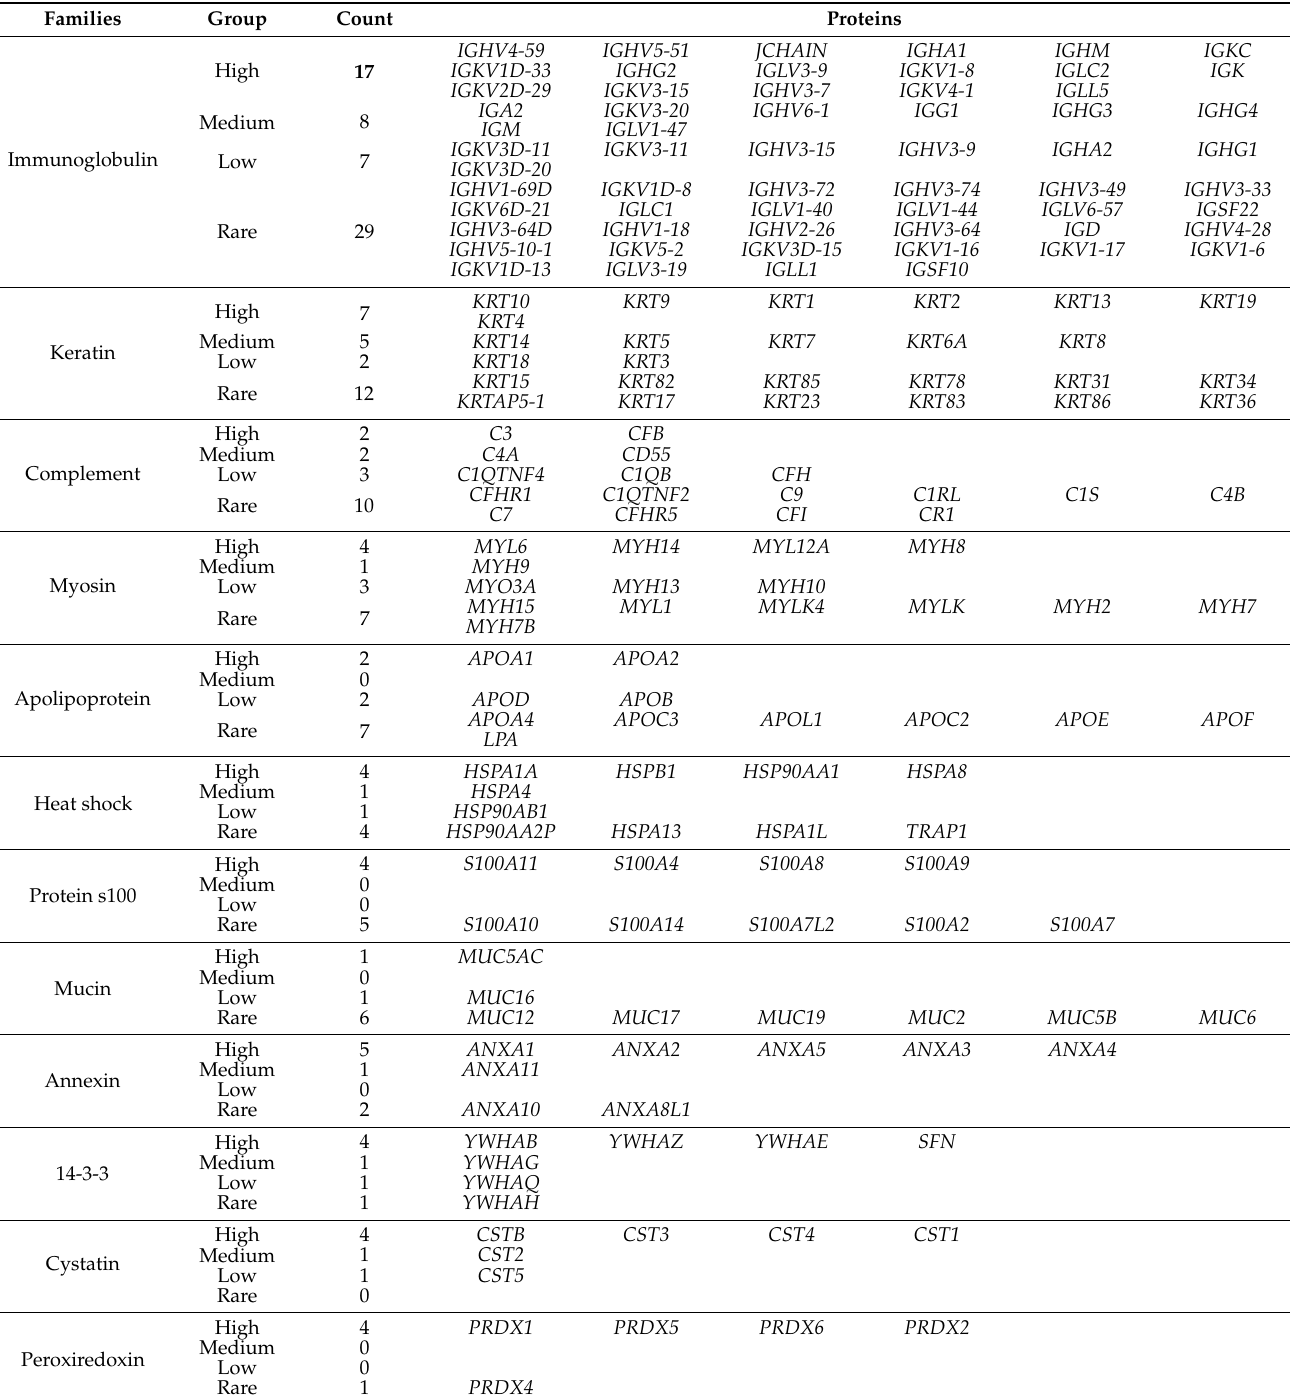
munoglobulins had the greatest number of highly-expressed proteins (17 proteins). All identified proteins within these families are listed in Table 4. Table 4. Major protein families identified in human tear